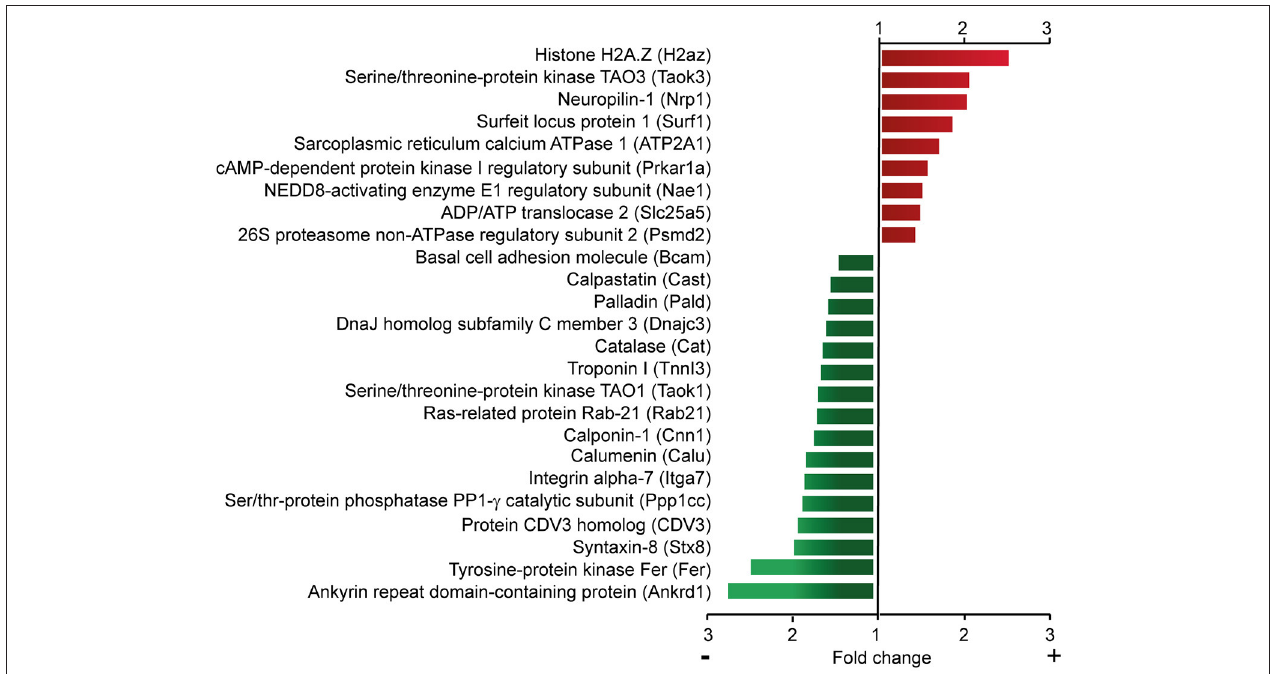
FIGURE 6 | Quantitative proteomic analysis of control and Ca v β 2 -downregulated NRCs. Subset of upregulated (red) or downregulated (green) proteins identified by quantitative mass-spectrometry-based analyses after Ca v β 2 downregulation in NRCs. A complete list of proteins is provided in Supplementary Table 1